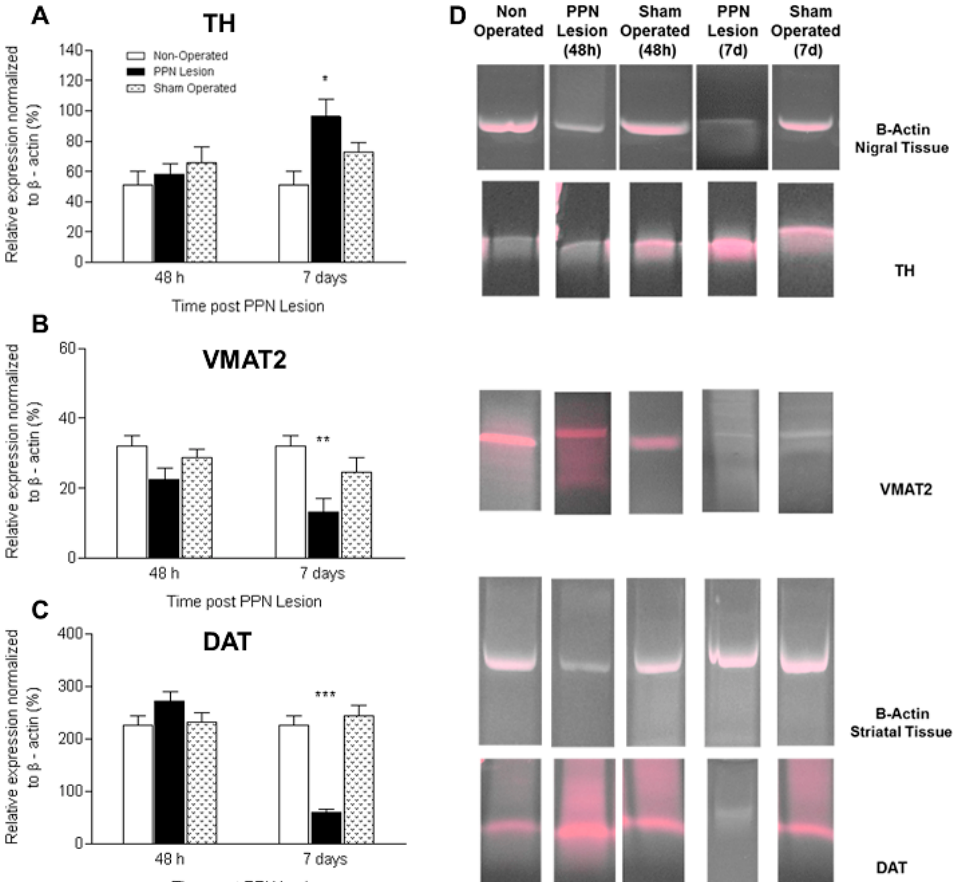
Figure 2. Effect of pedunculopontine nucleus (PPN) neurotoxic lesion on the mRNA expression of proteins related to dopaminergic homeostasis in nigral and striatal tissue. The study was by semi-quantitative RT-PCR, expressed as percentage of b-actin 48 h and 7 days after PPN lesion. Note that for the three proteins studied there were no significant differences between experimental groups 48 h after PPN injury ( p > 0.05). ( A ) Comparison between experimental groups of tyrosine hydroxilase mRNA expression in nigral tissue 7 days after PPN lesion (F (2, 12) = 5.34 p < 0.05); ( B ) Comparison between experimental groups of vesicular monoamine transporter 2 (VMAT2) mRNA expression in nigral tissue 7 days after PPN lesion (F (2, 12) = 6.16 p < 0.01); ( C ) Comparison between